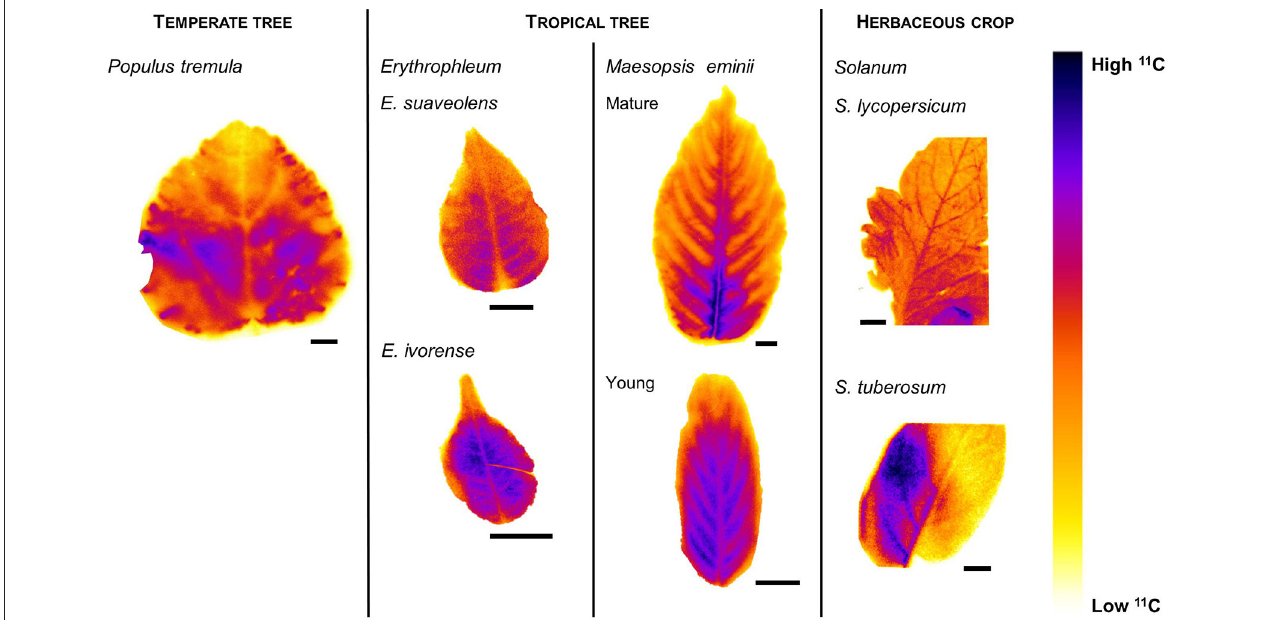
FIGURE 2 | Compilation of typical autoradiographs displaying 11 C tracer intensities in leaves of contrasting plant species. Populus tremula is a known passive loader, illustrating lower tracer intensities in major veins compared to mesophyll. Erythrophleum spp. are tropical tree species, both showing the projected passive loading strategy with lower activities measured in the major veins. Young Maesopsis eminii leaves showed lower intensities in major veins compared to mesophyll indicating passive loading, but their mature counterparts showed highest tracer intensities around the major veins. Solanum spp. are known to be active loaders and showed higher intensities in major veins than in mesophyll. Scale bars are